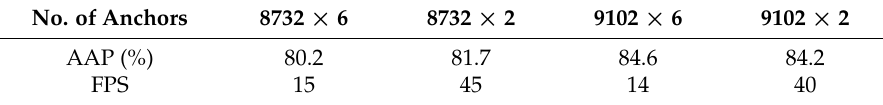
Table 5. Time and accuracy trade-off of the proposed one-stage method.